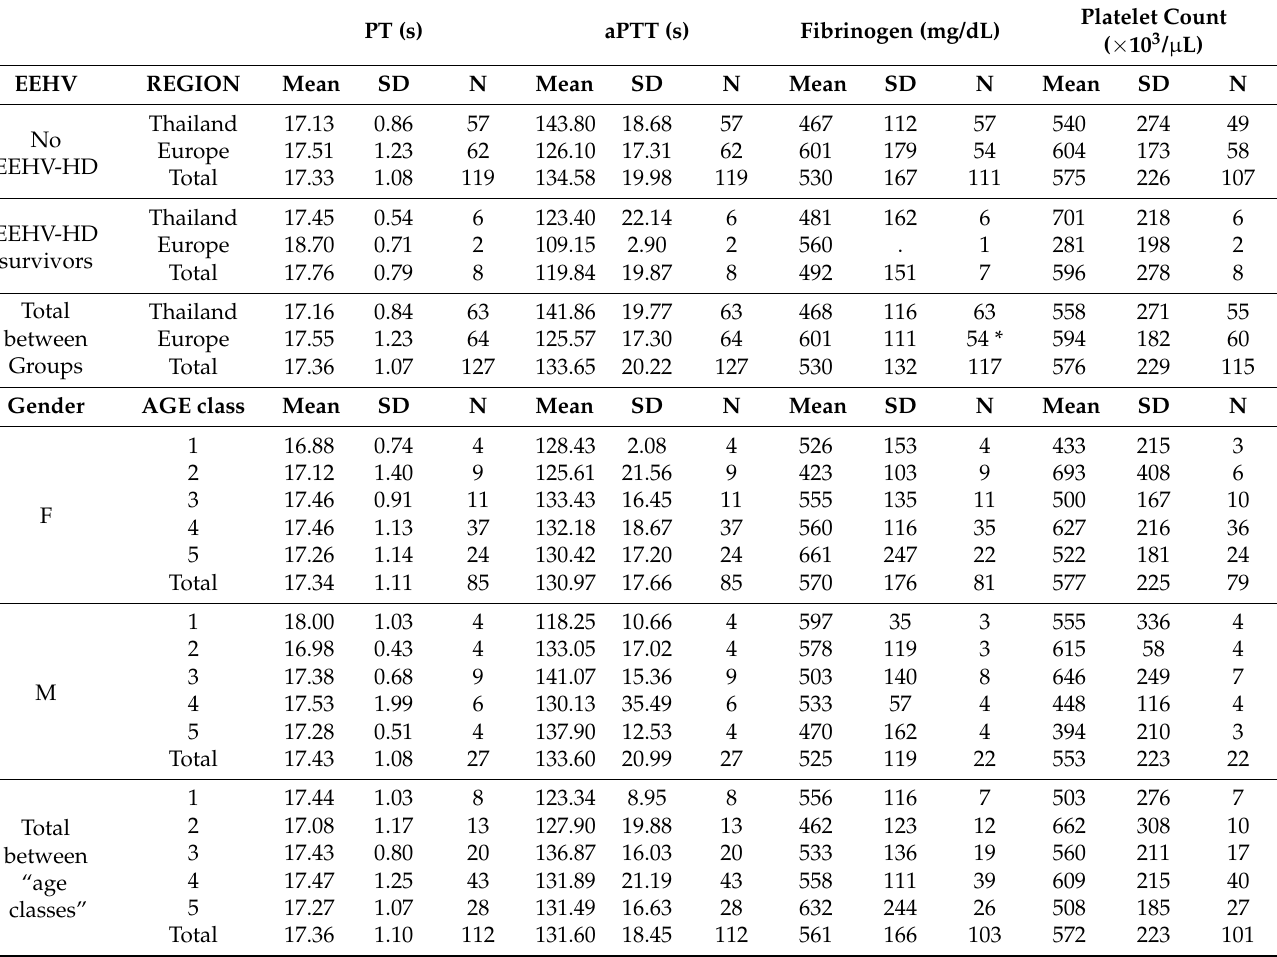
Table 2. Estimated mean and SD of prothrombin time (PT), activated partial thromboplastin time (aPTT), fibrinogen, and platelet counts for different groups of individuals, sorted according to study region, gender, age class, and known presence or absence of